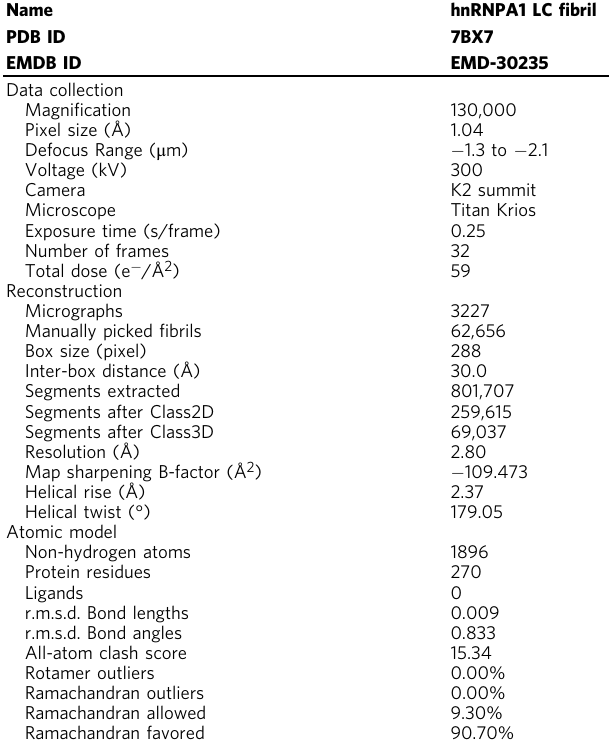
Table 1 Statistics of cryoEM data collection and re fi nement.